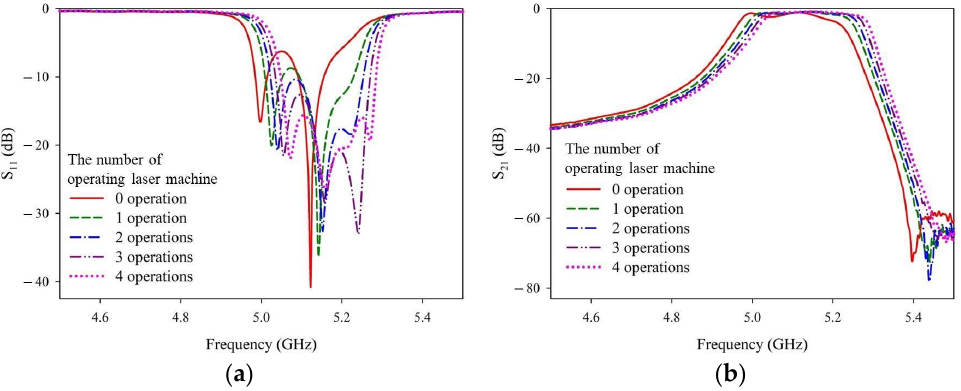
Figure 15. Measured ( a ) S 11 and ( b ) S 21 values after different numbers of operations with the 4w_30k_300_re20 recipe. The solid red curves represent ceramic filter samples without laser trimming. Figures